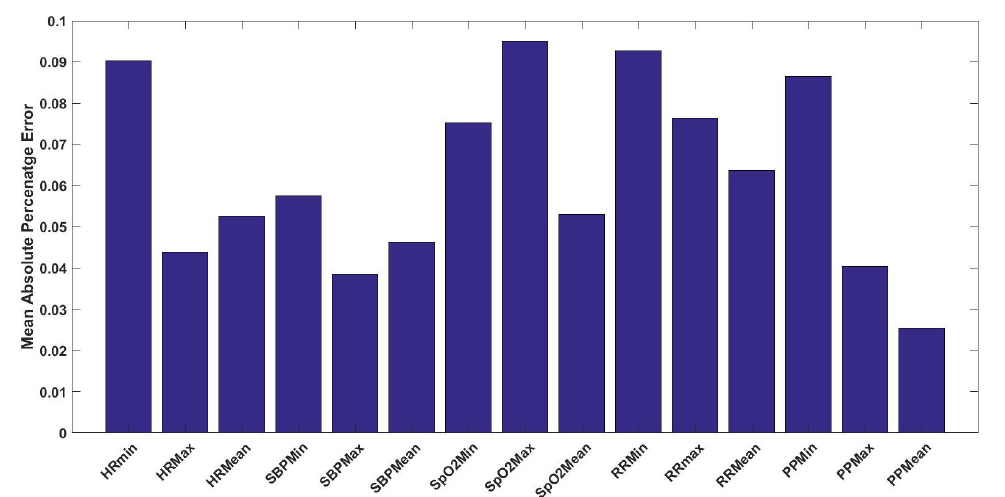
Figure 12. The mean absolute percentage error (MAPE) of the predicted statistical values (i.e., minimum, maximum, and mean) for the vital signs of HR, SBP, Sp O 2 , RR, and PP for the upcoming hour for dialysis